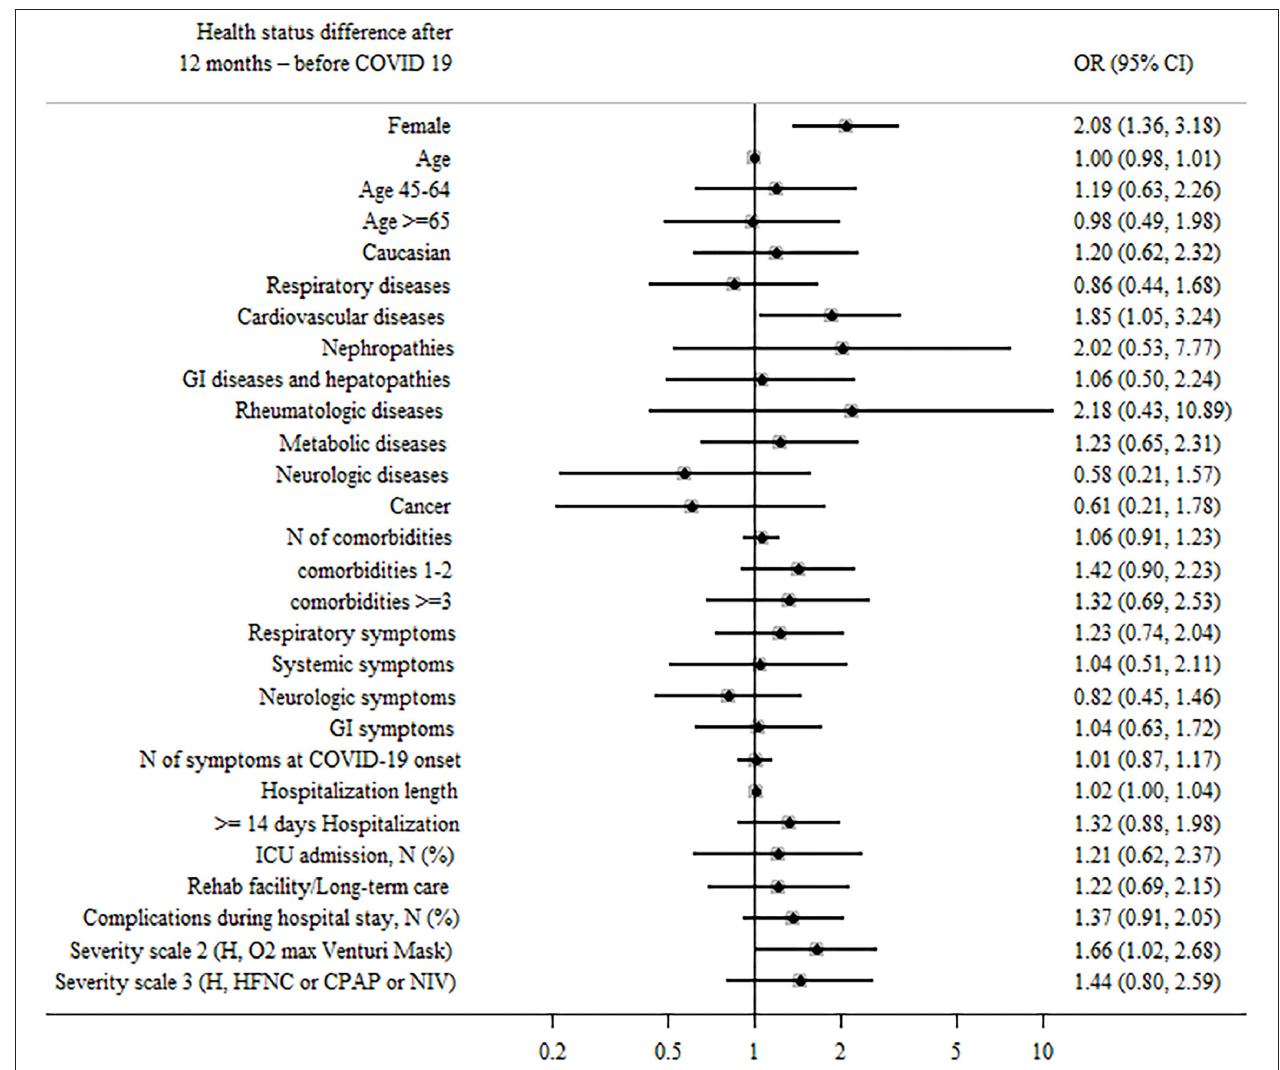
FIGURE 4 | Patient factors associated with health status difference after 12 months—before